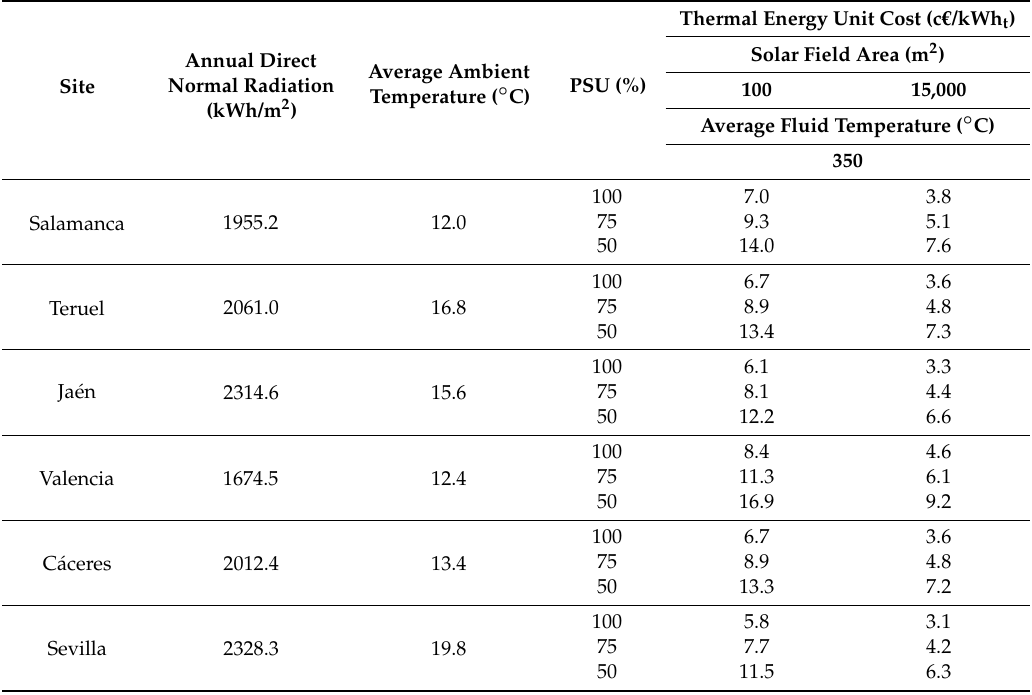
Figure 10. Thermal energy generation cost—Large size solar field area. The previous graphs show the PSU parameter, fluid temperature and solar field area importance have significant influence on the thermal energy generation cost. As can be observed for all bar groups, the thermal energy generation cost increases proportionally as the PSU decreases. If CPC technology results are analysed, the extreme situation is observed when the average fluid temperature is around 150 °C. The influence of the average fluid temperature is lower in the case of LFC technology. These results show again the importance of the coupling in time between the thermal energy generated by the solar installation and the thermal energy demanded by the industrial process. In general, terms and according to the expressions proposed in Section 4, it can be stated that by reducing the PSU from 100% to 50%, double the thermal energy generation cost. Moreover, when comparing graphs above, the influence of the solar field area is also evident. As expected by the cost structure shown in Section 2, the costs of thermal energy generation (directly dependent on investment costs) are reduced by increasing the solar field area. This reduction is especiallystrikingin the case of PTC technology. Regarding the particular case of Spain and conversely of what happened when analyzing the thermal energy generated by the solar installation, higher costs are linked to Vitoria, while lower costs for Seville. Finally, Table 24 summarizes the thermal energy unit costs of conventional energy sources analysed in this paper considering the three scenarios described in Section 3. Given the wide range of existing electricity and natural gas rates depending the consumers characteristics, the two extreme groups has been included in this table, I1 and I6 Groups and IA and IG Groups respectively. As in